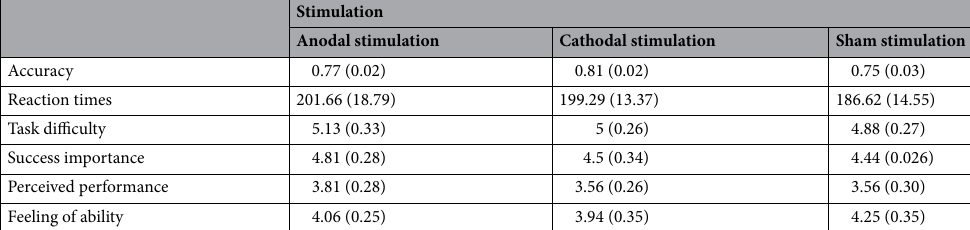
Table 3. Means and standard errors (in parentheses) of task performance and verbal measures. Task difficulty, success importance, perceived performance, feeling of ability were measured with Likert scales ranging from 1 (not at all) to 7 (very